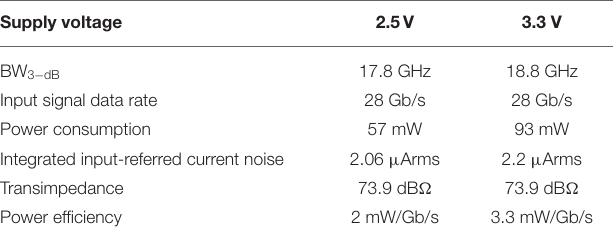
TABLE 6 | One-channel TIA performance summary at different supply